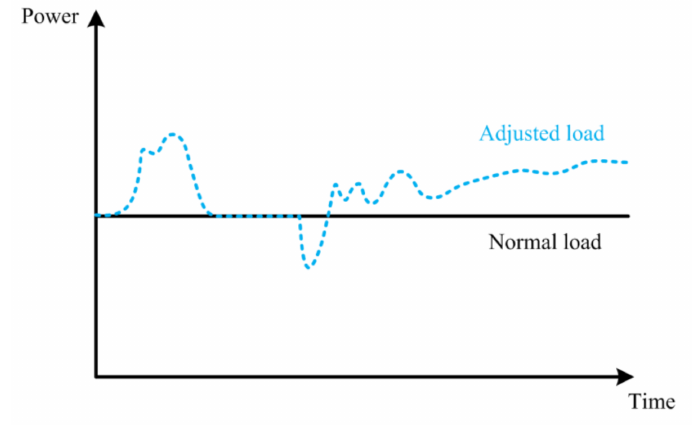
Figure 6. Schematic diagram of titanium alloy load regulation characteristics.